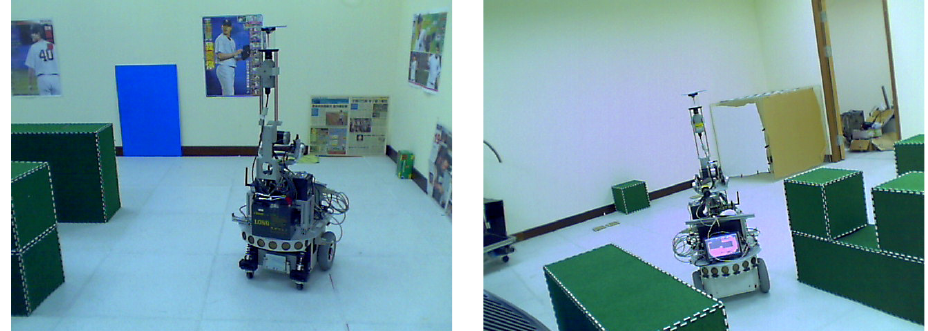
Figure 11. The indoor environment for robot navigation and image acquisition in our experiments. trajectory computation for various locations. In our current implementation in the indoor scene, the 260 experiment is limited to a relatively short distance for navigation. Except for the issues on the available 261 environment, the proposed technique will suffer the drift error if the vertical lines are vanished from 262 the viewpoints. 263 Table 1. the position estimates and the estimation errors at several locations. The errors are increased for the base points far away from the mobile robot.